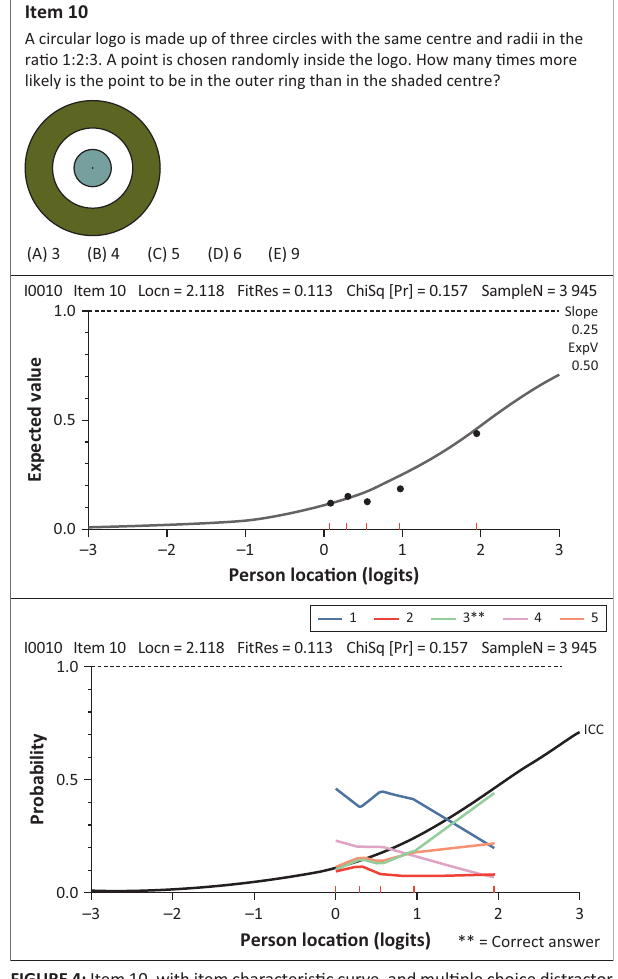
FIGURE 4: Item 10, with item characteristic curve, and multiple choice distractor plot.